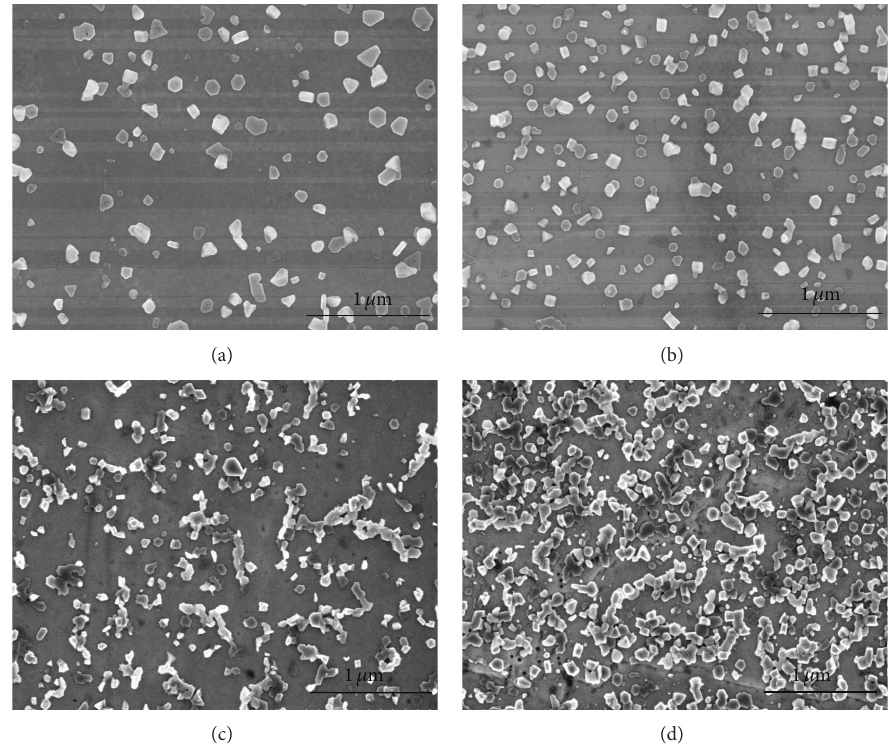
Figure 8: SEM images of Zn deposits on GaN electrode with an applied potential of − 1.4V. The deposition time was (a) 10, (b) 20, (c) 40, and (d)